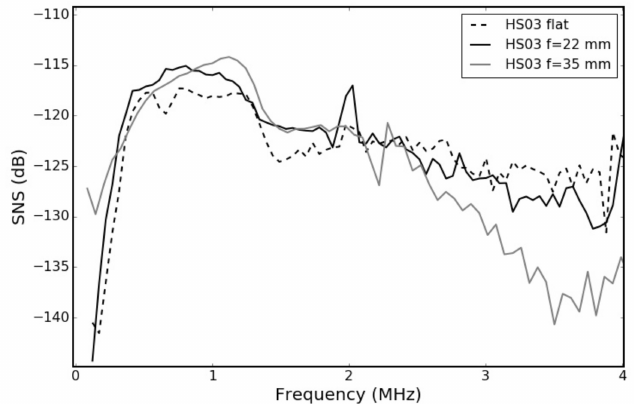
Figure 7. SNS vs. frequency for HS03 transducers in pulse-echo mode in water: flat and spherically focused (two focal distances: 22 and 35 mm).